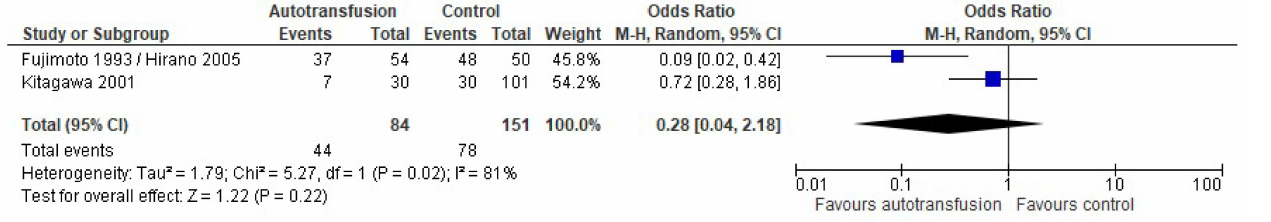
Figure 6. Forest plot for recurrence in hepatectomy patients with autotransfusion and without. Blue squares indicate individual effects and black diamond illustrates overall effect.